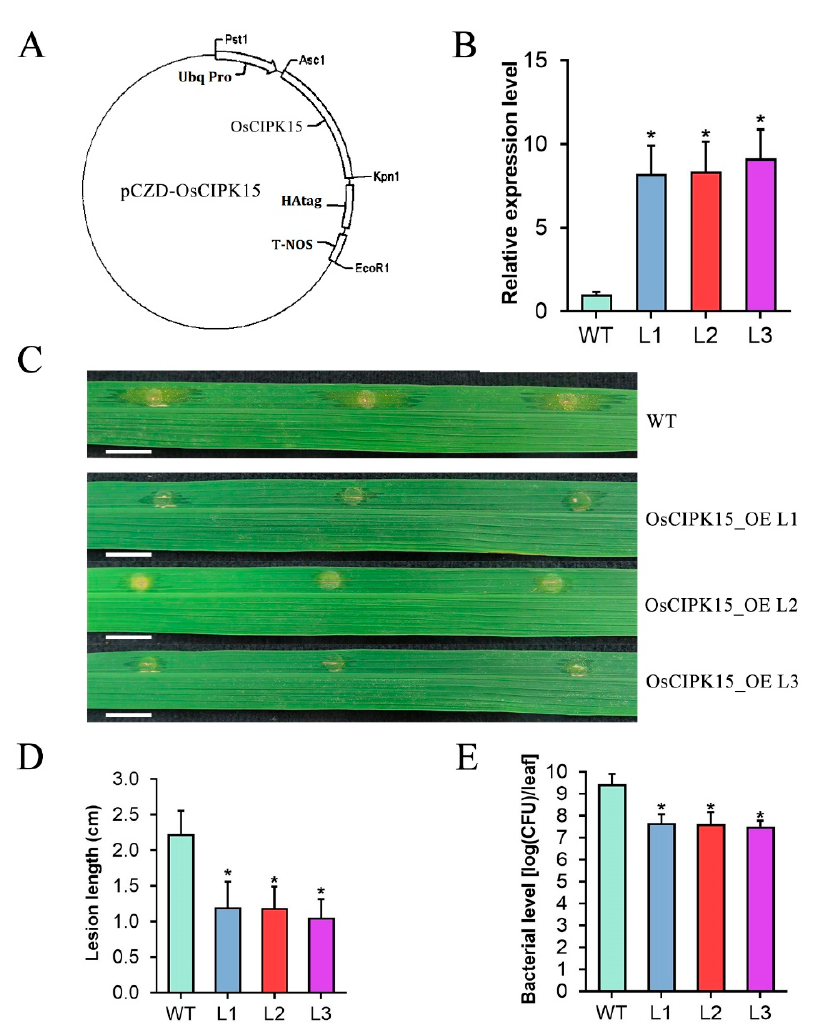
Figure 7. OsCIPK15 strongly positively modulates rice resistance to Xoc . ( A ) Schematic representation of pCZD-OsCIPK15 vector. ( B ) OsCIPK15 gene expression in 5-week-old OsCIPK15-OE lines. ( C ) Rice bacterial leaf streak symptoms in WT and OsCIPK15-OE T 2 lines at 10 d post inoculation (dpi) with Xoc strain oxy04 (OD 600 = 1) by leaf infiltration method. Bar: 1 cm. ( D ) Statistical analysis of lesion length at 10 dpi. ( E ) Statistical analysis of bacterial level in planta at 10 dpi. Data were analyzed by Student’s t -test and shown as the mean ± SD. Asterisks indicate significant difference between data from OsCIPK15-OE lines (L) and those from wild-type plants (WT) (* p < 0.05).